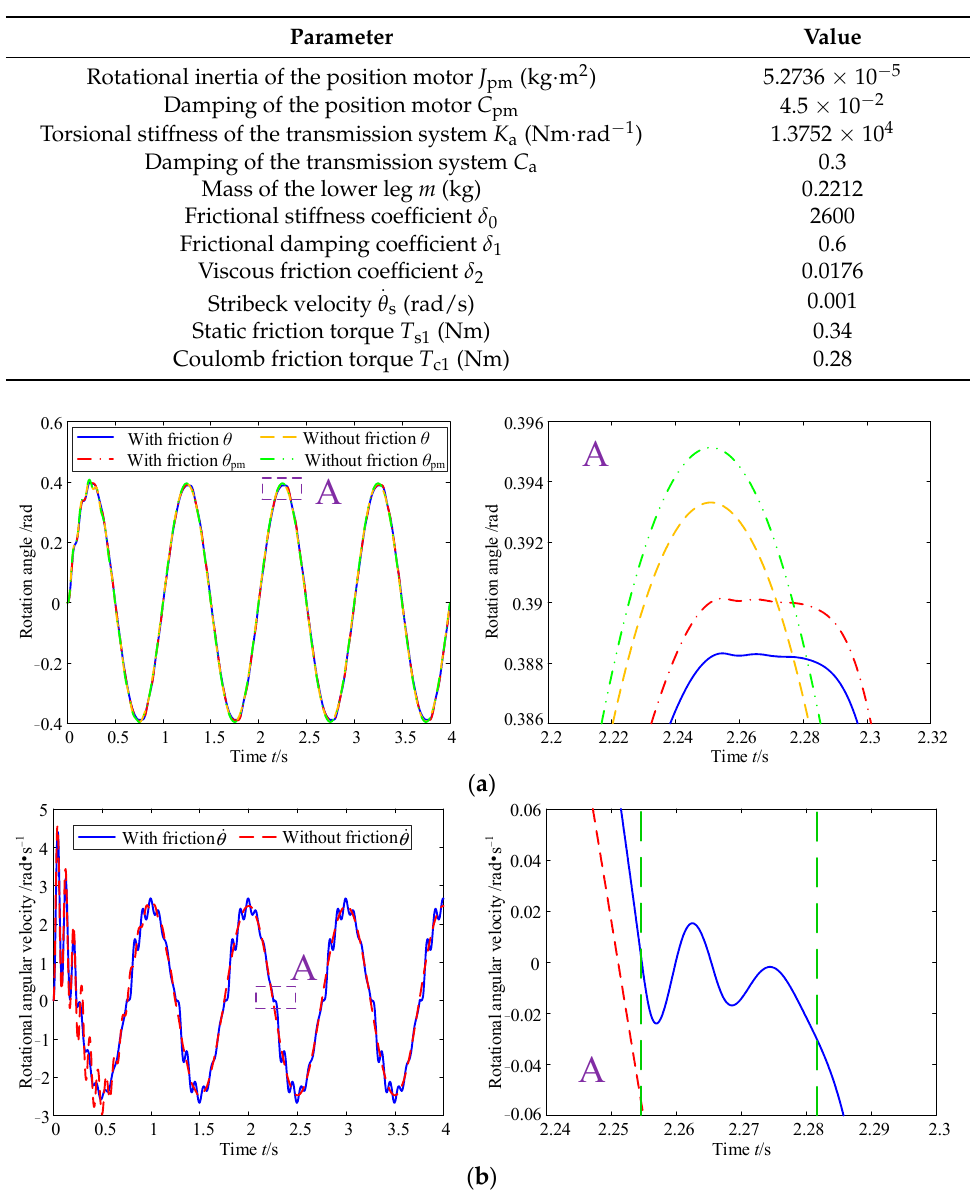
Figure 2. Effect of friction on the dynamic performance of the variable stiffness actuator system at constant stiffness: ( a ) rotation angle and ( b ) rotational angular velocity.